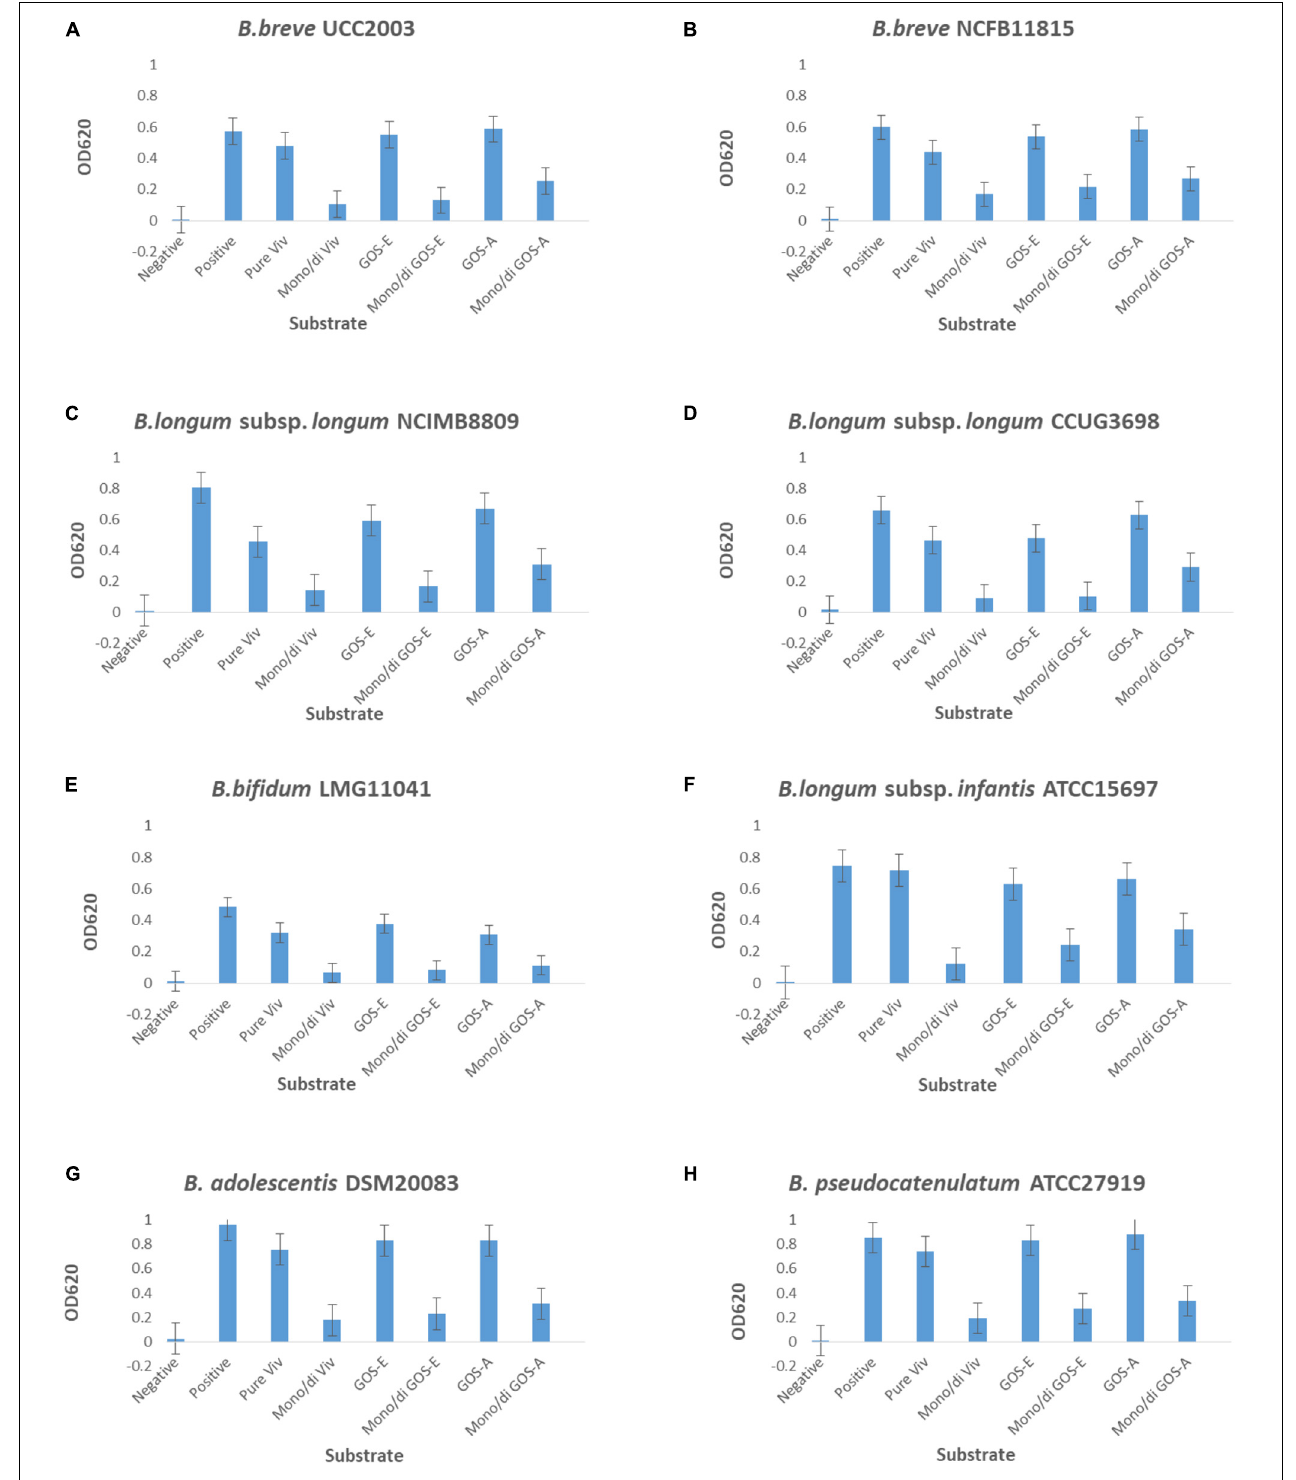
FIGURE 3 | Final OD 620 nm values after 24 h of growth of (A) S. breve UCC2003, (B) B. breve NCFB11815, (C) B. longum subsp. longum NCIMB8809, (D) B . longum subsp. longum CCUG3698, (E) B. bifidum LMG11041, (F) B . longum subsp. infantis ATCC15697, (G) B. adolescentis DSM20083 and (H) B. pseudocatenulatum ATCC27919. Negative, no sugar; Positive, lactose; Pure Viv, purified Vivinal GOS; Mono/di Viv, Mono/di Mix corresponding to purified Vivinal GOS; GOS-E, purified GOS obtained by enzymatic reaction employing BgaE; Mono/di GOS-E, Mono/di Mix corresponding to GOS-E; GOS-A, purified GOS obtain by enzymatic reaction employing BgaA; Mono/di GOS-A, Mono/di Mix.